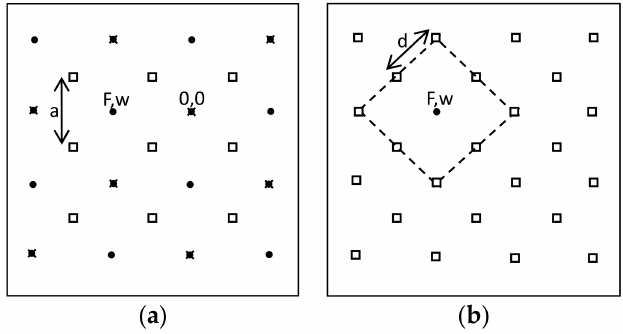
Figure 3. Schematic of a continuous micromirror array. ( a ) Superposing two kinds of concentrated load in the middle of the plate. ( b ) Concentrated load kind in practice.